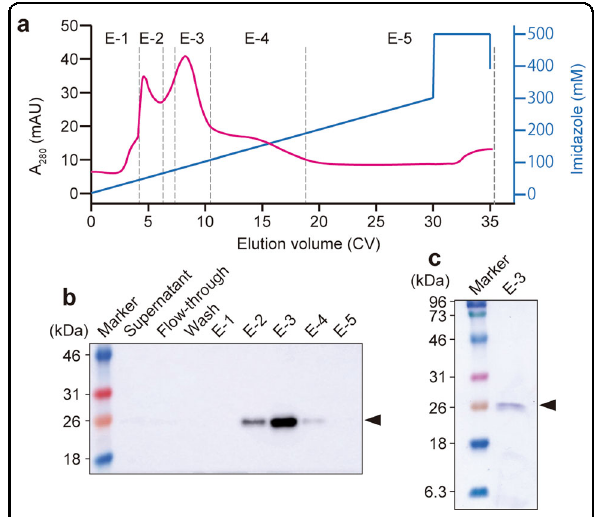
Fig. 2 Puri fi cation of rmIL-1Ra. a Chromatogram of protein elution. Protein adsorbed on a His-Trap column was eluted by adding imidazole. The eluted protein was collected in fi ve fractions (E-1 to E-5) based on A 280 . b The presence of rmIL-1Ra in each fraction was analyzed by Western blotting using an anti-His-tag antibody. c Results of analysis of E-3 by SDS-PAGE (CBB staining). Secretory rmIL-1Ra (black arrowhead: 21.8 kDa).